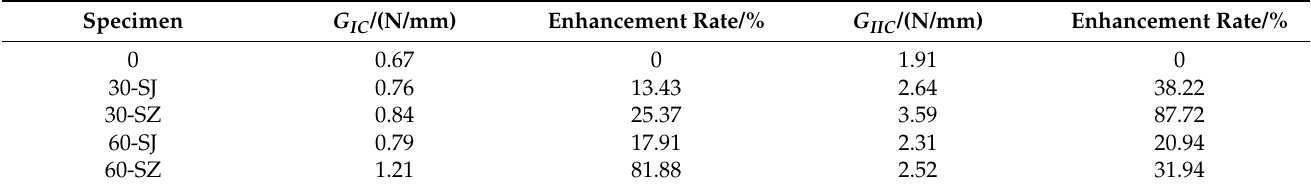
Figure 14. Load-displacement curves of specimens by ( a ) DCB tests, ( b ) ENF tests. Table 1. Interlaminar fracture toughness test results and enhancement rates compared with the specimen without